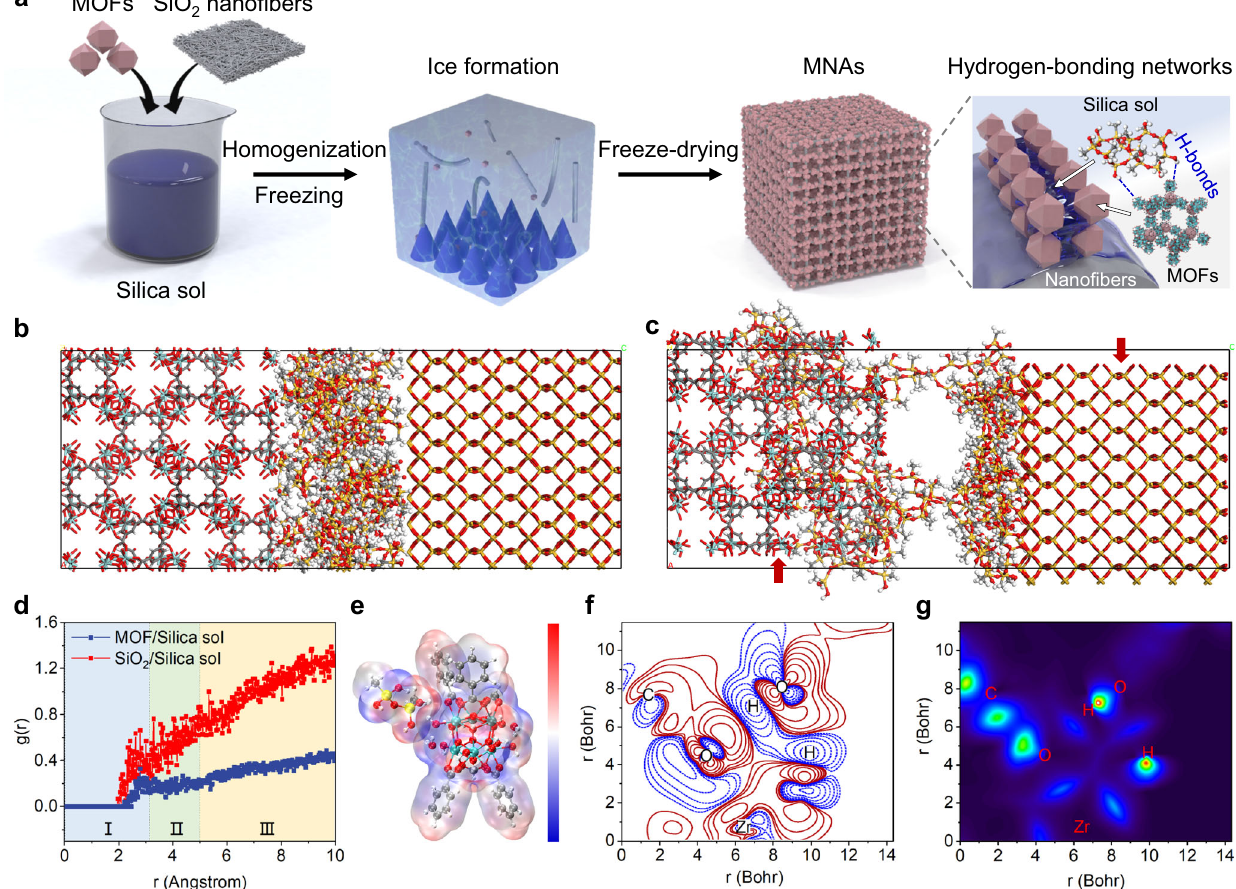
Fig. 1 | Design strategies for interfacial engineered MOF aerogels. a Fabrication procedures ofthe interfacialengineered MNAs. Simulationsof in-situ alignment of silica sol chain before ( b ) and after ( c ) con fi ned shear. The corresponding radial distribution functions ( d ). e ESP of the optimized MOF/silica sol complex is drawn overtherangeof − 0.03to 0.03.Theelectrondensitydifferenceisosurfaces( f )and